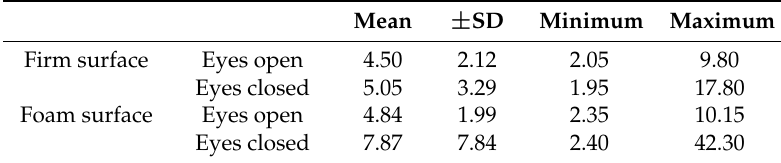
Table 3. Sensory Analysis (SA); anterior-posterior sway during the SA during single stance tests in m/s 2 .